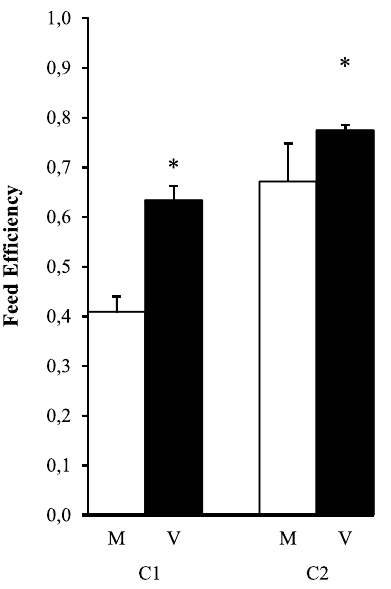
Figure 4. Feed efficiency (FE) during the restricted V-challenge. Two families of rainbow trout with nutritional history (M or V) received for 4 weeks diet V at 0.75% of their body weight (restricted feeding). Values are means 6 SEM (n=2). The significance of the effects of nutritional history, family (C2 . C1) and interaction (P values, 2-way ANOVA) is provided in the results section, * shows a significant effect of nutritional history (V . M, p , 0.05).